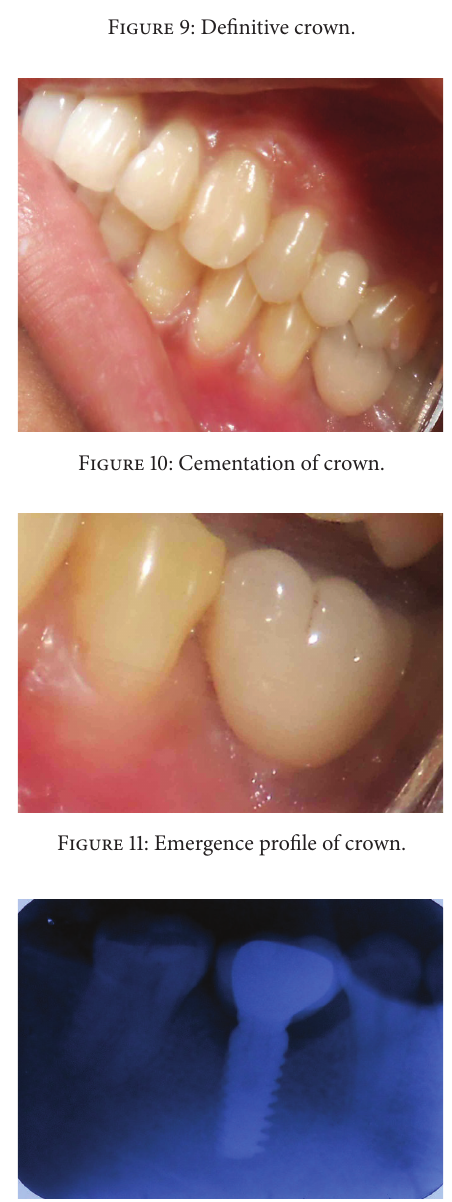
Figure 12: IOPA after